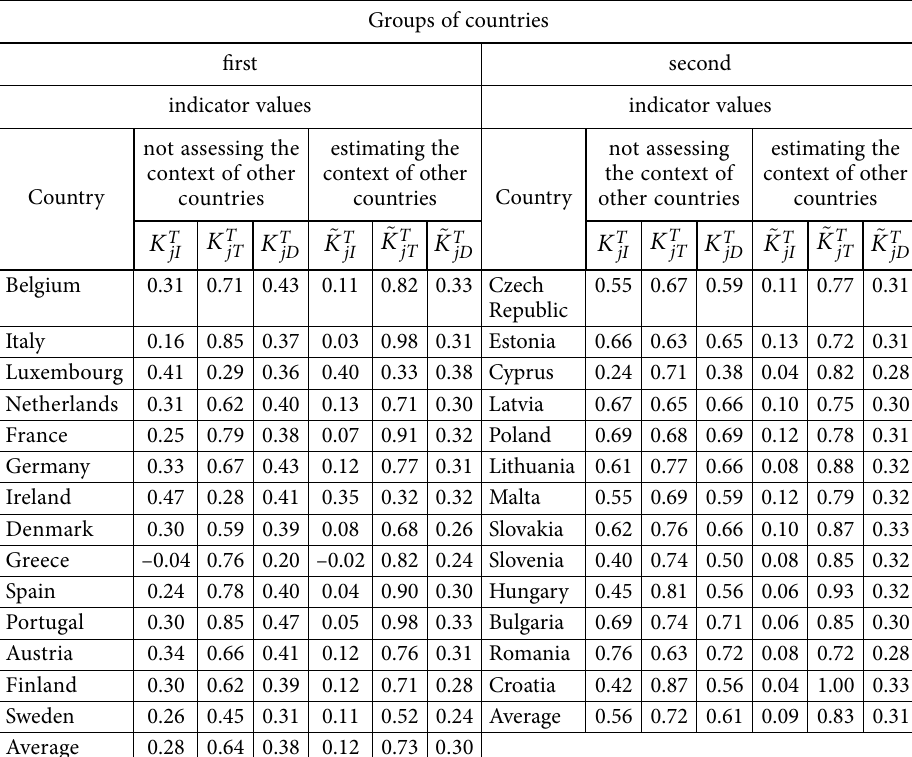
Table 3. Indicators of economic development in the European Union for the period 2004–2019 (source: compiled by the authors) Groups of countries first second indicator values indicator